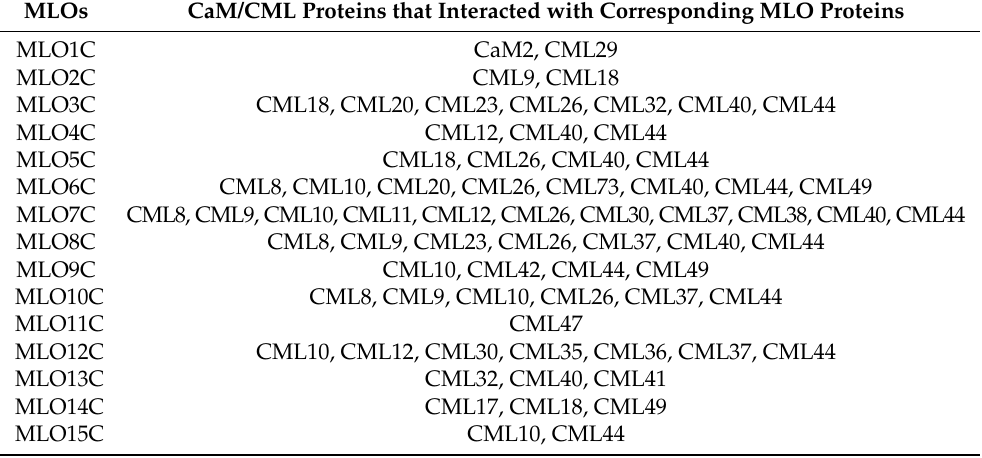
Table 1. Interactive protein pairs between MLO and CaM/CML family. MLOs CaM/CML Proteins that Interacted with Corresponding MLO Proteins MLO1C CaM2, CML29 MLO2C CML9, CML18 MLO3C CML18, CML20, CML23, CML26, CML32, CML40,